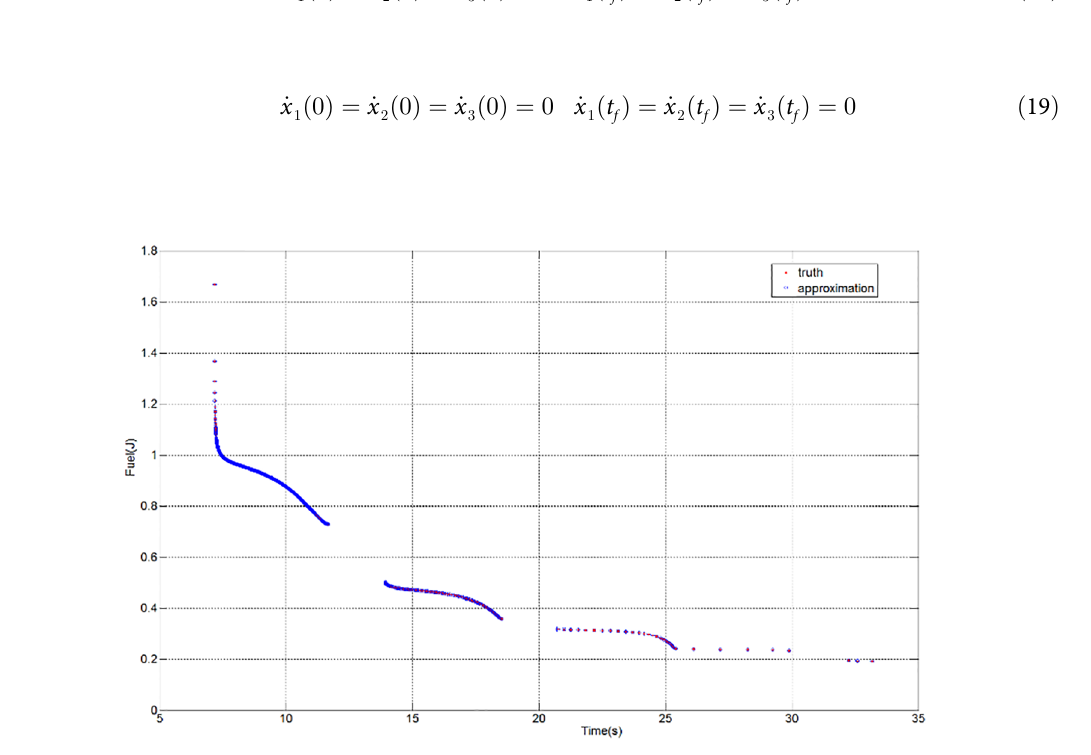
Fig 9. PF of time/fuel optimal control